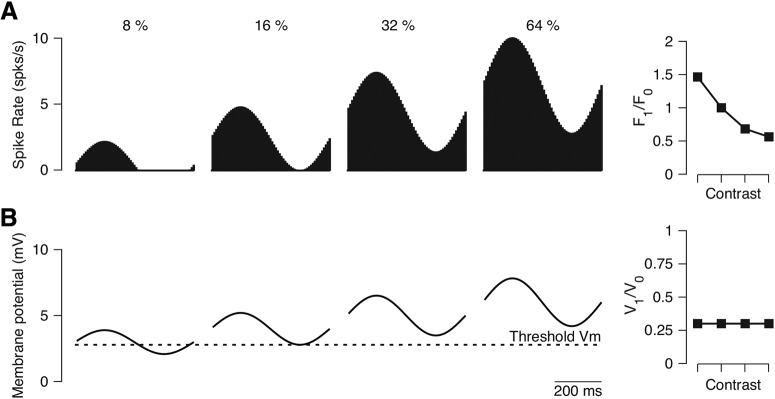
Threshold nonlinearity model (“iceberg” model) for a contrast-dependent transformation between simple and complex cells in mammalian V1 neurons. A, Spiking responses of a model neuron relative to contrast. As contrast increases, the spiking rate of the model neuron increases (right). The modulation ratio (F1/F0) decreases with increasing contrast due to relatively large increases in the mean spiking rate (F0) compared to the F1 component. B, Membrane potential responses of the model neuron relative to contrast. As the contrast increases, the amplitude of the membrane potential increases. The matched increases in the V0 and V1 components of the responses generate a steady modulation ratio (V1/V0) at all contrasts.